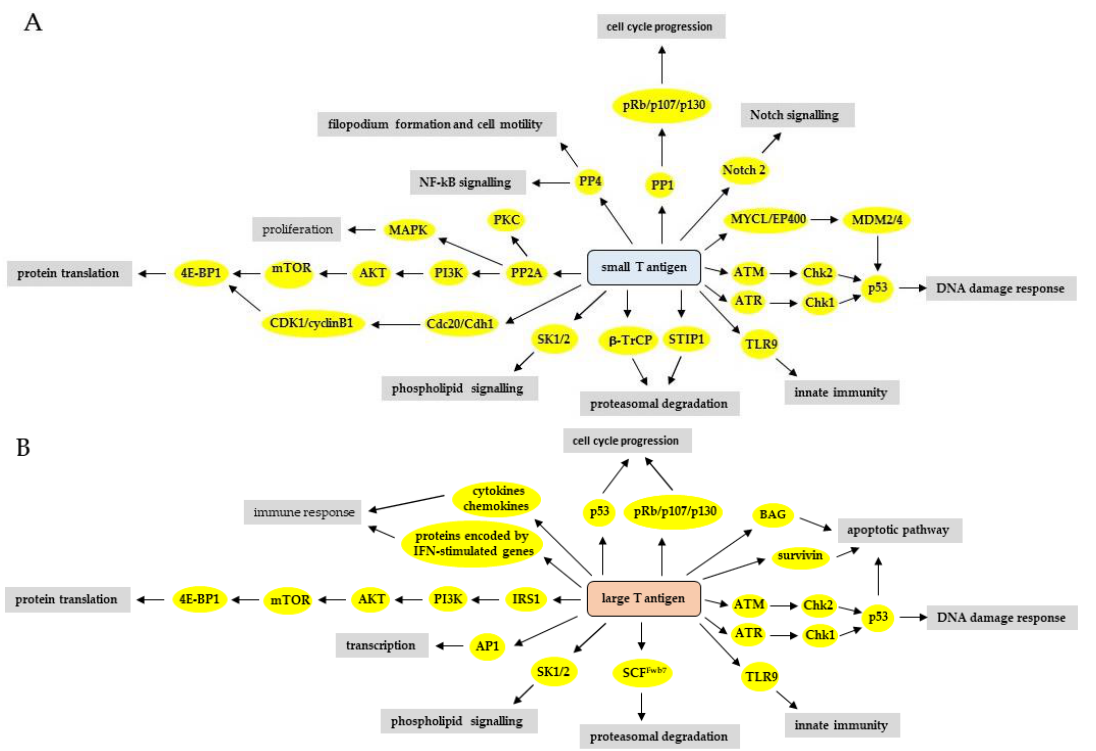
Figure 2. Interaction between HPyV small T antigen ( A ) and large T antigen ( B ) and different signaling pathways. See text for details.